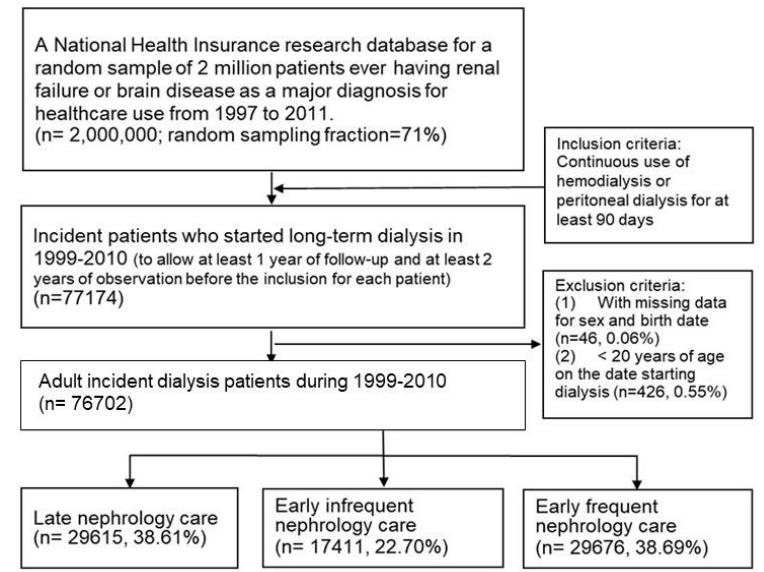
Figure 1. Flow chart of cohort establishment.